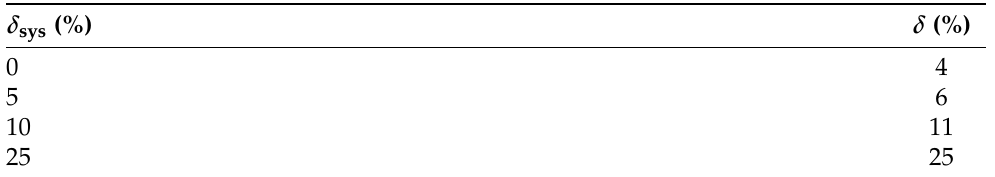
Table 6. Total relative uncertainty, δ , as a function of systematic uncertainty in the correction terms ∆ H Pu ( T eu ) and ∆ H liq fus